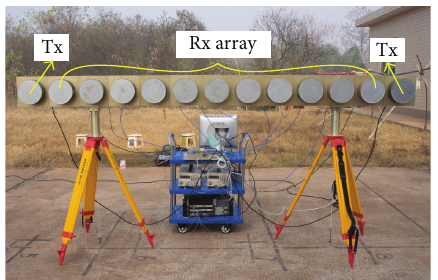
Figure 6: Photograph of the through-the-wall VAR system.